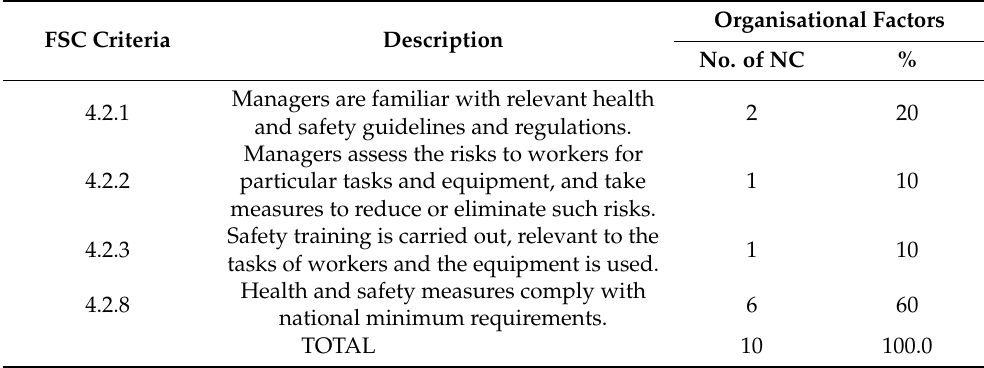
Table 4. Analysis of the personal risk factors category related NCs and their relation to the FSC requirements.